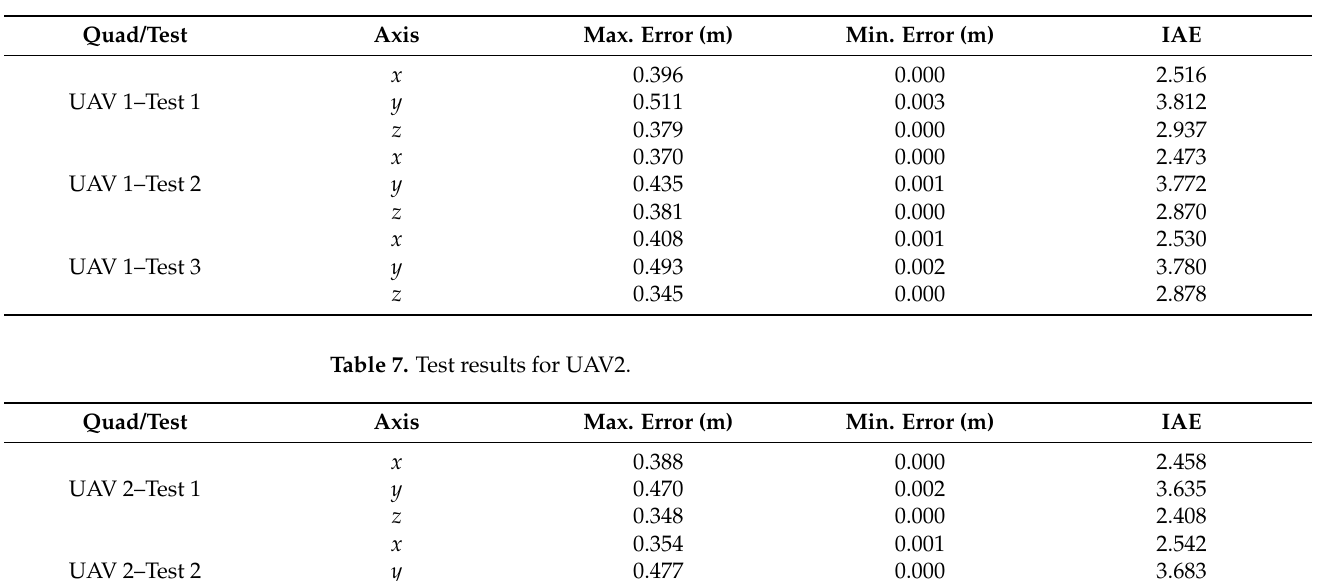
Table 6. Test results for UAV1.